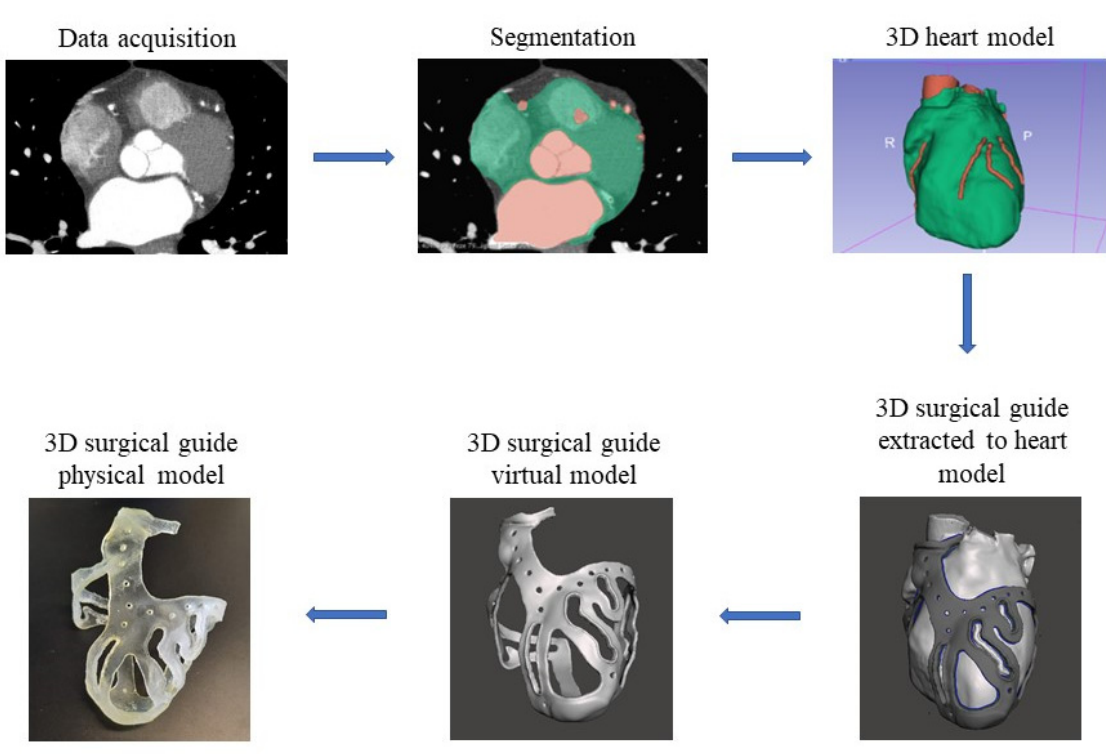
Figure 1. Workflow from the stack of medical images to the surgical guide.